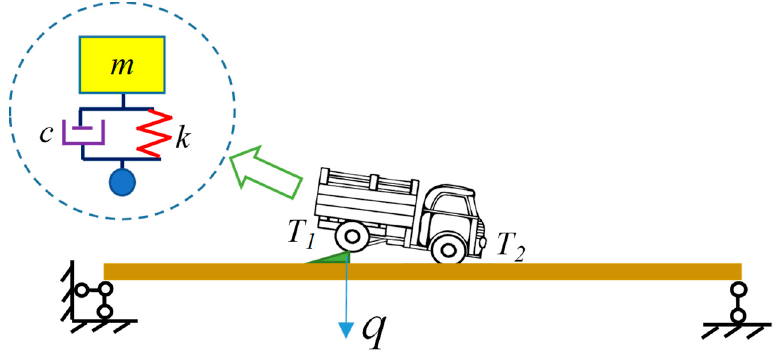
Figure 2. Diagram of vehicle bump on a bridge using a 1-DOF vehicle model.